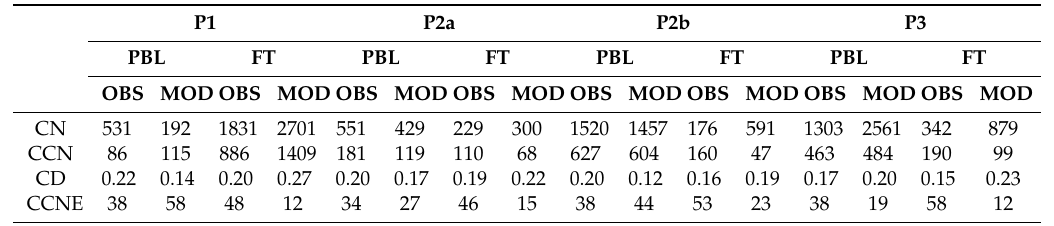
Table 6. Trimean values of condensation nuclei (CN) cloud condensation nuclei (CCN) concentration, cloud, a6rosol hygroscopicity, critical diameter, and condensation nuclei efficiency (CCNE) measured aboard the ATR-42 and simulated by WRF-CHIMERE. The values are calculated in each period analyzed in boundary layer (PBL) and free troposphere.